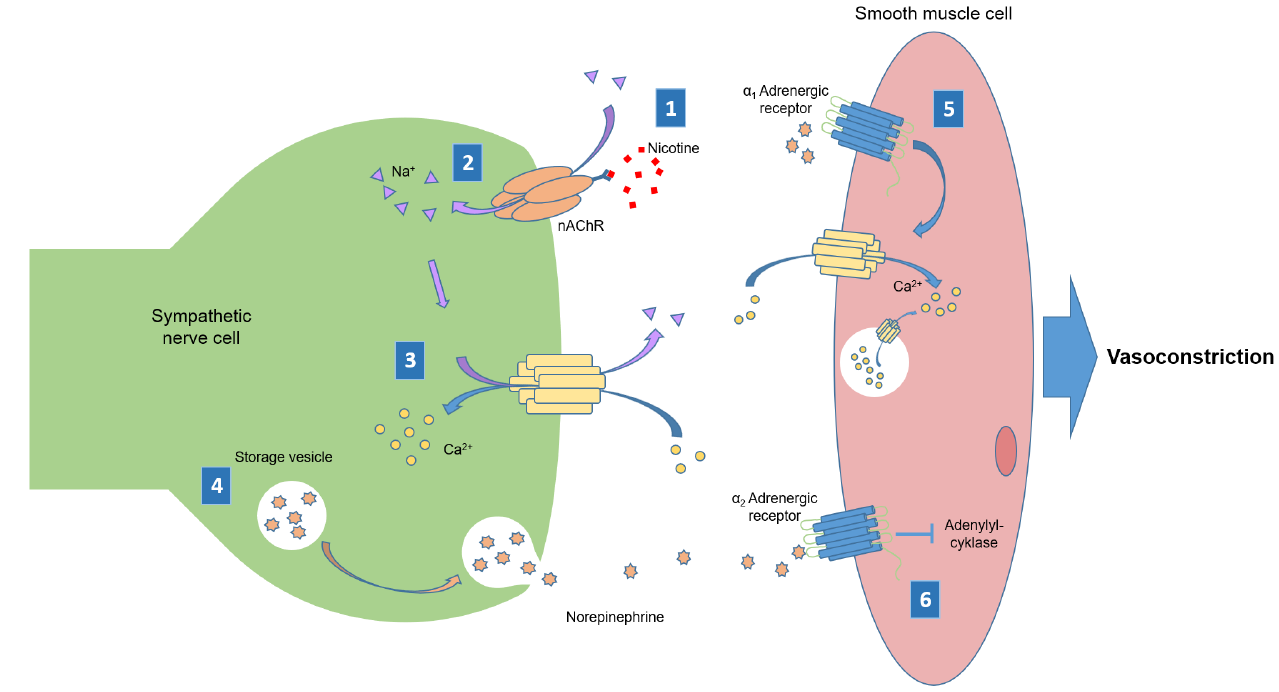
Figure 1. Nicotine stimulation of sympathetic vasoconstriction. 1) Nicotine binds to the nicotinic acetylcholine receptor (nAChR) causing a conformational change. 2) Sodium ions (Na + ) enter the cell through the central pore of the nAChR. 3) Ion exchange leads to influx of calcium ions (Ca 2+ ) into the cell causing depolarization. 4) Depolarization stimulates exocytosis of stored norepinephrine. 5) Norepinephrine binds to α adrenergic receptors on the smooth muscle cell surface, stimulating calcium ion influx and release of stored calcium. 1 6) Norepinephrine also binds to α 2 adrenergic receptors on the smooth muscle cell surface, which causes downstream inhibition of adenylyl cyclase activity. Both these mechanisms cause smooth muscle contraction and, consequently,